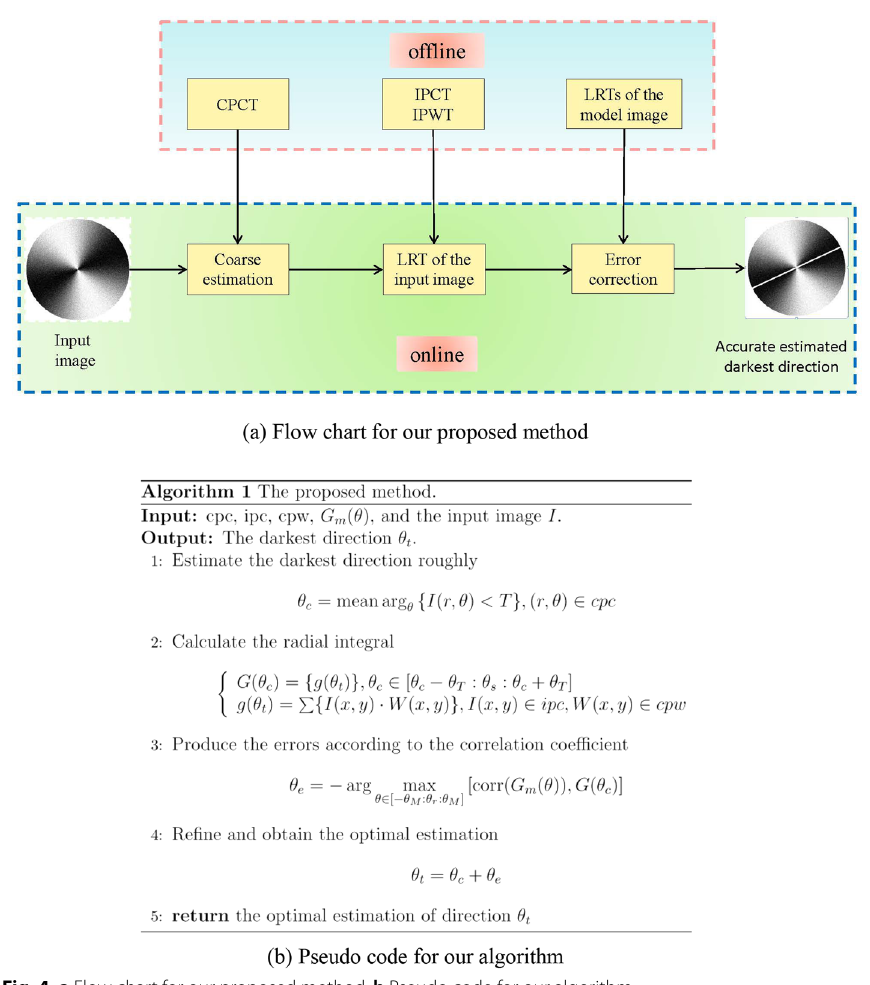
Fig. 4 a Flow chart for our proposed method, b Pseudo code for our